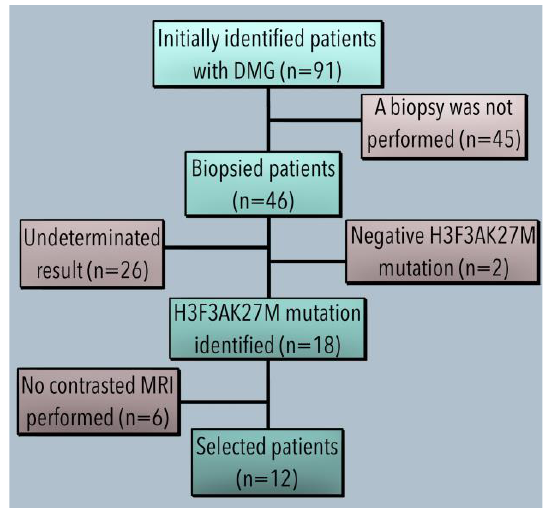
Figure 1. Patient selection process.